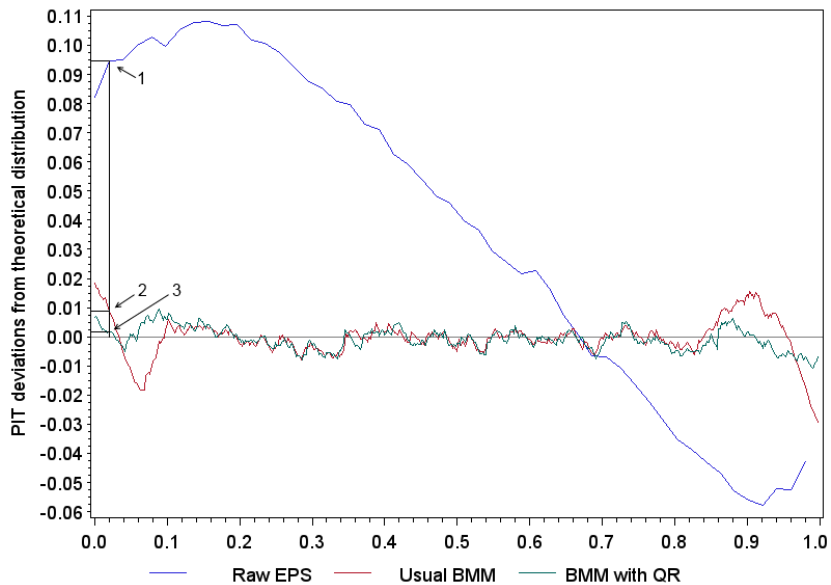
Fig. 5. Comparison of probability integral transform deviations from theoretical distribution for horizon 3. The point labeled “1”, with coordinates ( 0 . 02 , 0 . 095 ) , shows that, for raw ensemble prediction system (“raw EPS”), the realized temperature is lower than 2% of the simulated values on 2 + 9 . 5 = 11.5% (rather than 2%) of the dates. For best member method, denoted by “Usual BMM” (respectively best member method with error modeling using quantile regression, denoted by “BMM with QR”), point labeled “2” (respectively “3”) realized temperature is lower than 2% of the simulated values on 2.9% (respectively 2.2%) of the dates.